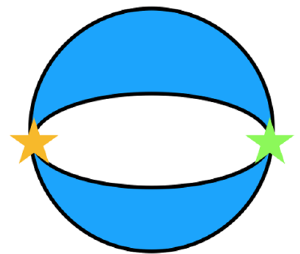
Figure 5. Diagram associated to the U ( f ) (cid:2) U ( N f (cid:0) f ) invariant term discussed in section